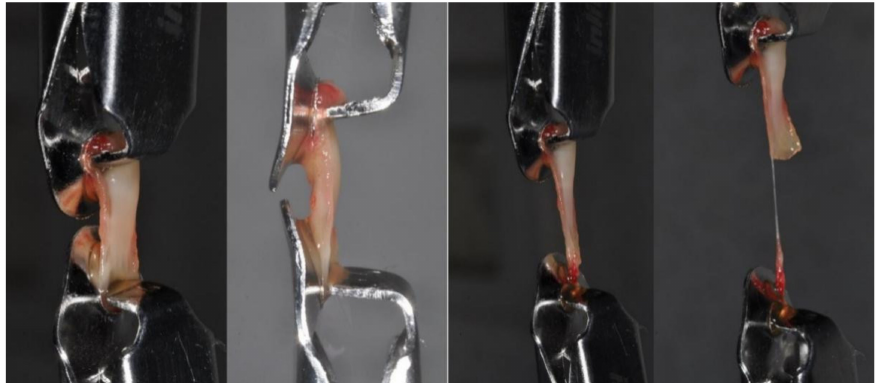
Figure 5. APG during tensile strength under tensile